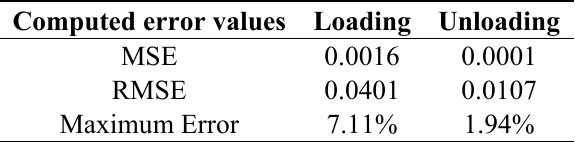
Table 5. Predicted median square (MSE) and quadratic (RMSE) error values for a PBR-CB composite material.